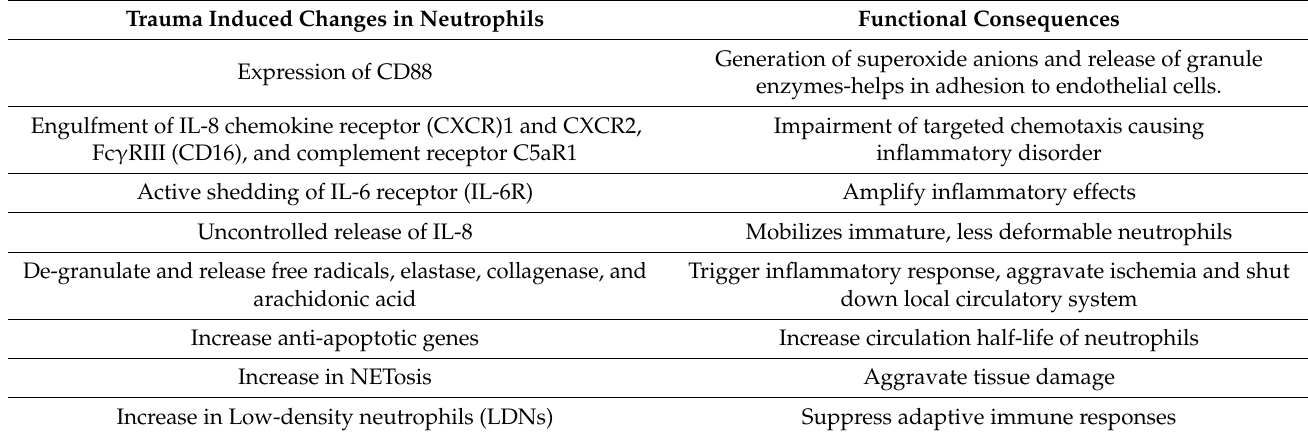
Table 1. CTI induced alterations in neutrophils and their functional